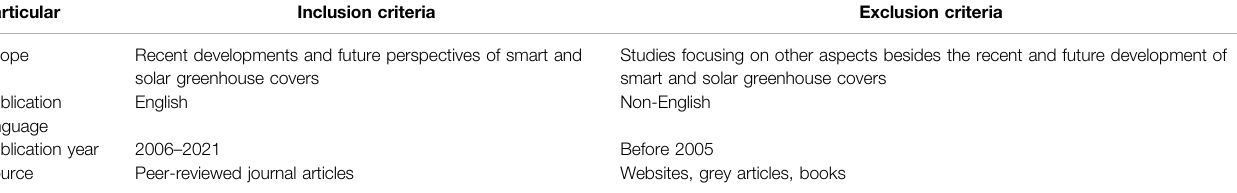
TABLE 1 | Inclusion and exclusion